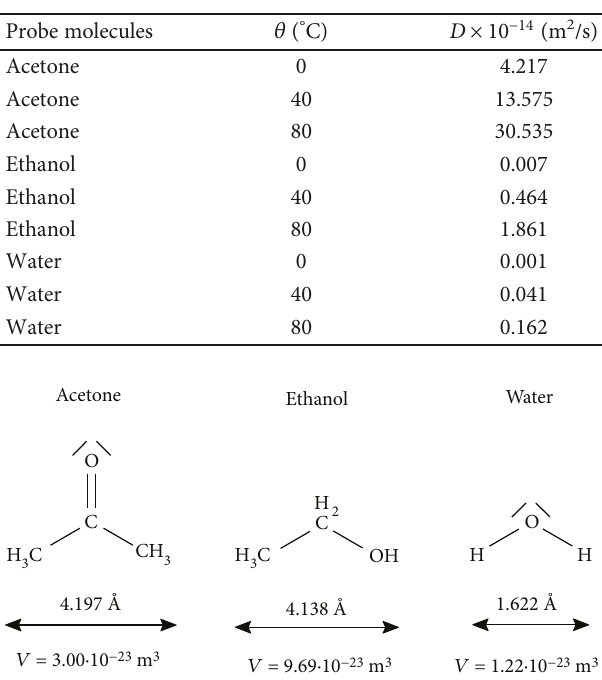
Table 1: Di ff usion coe ffi cient ( D ) for sorption of acetone, ethanol, and water into Estane samples at three di ff erent temperatures ( θ ).